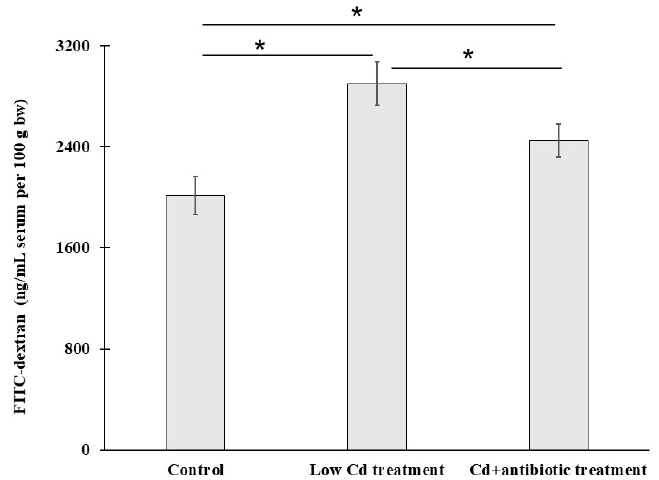
Figure 5. Fluorescein-isothiocyanate-dextran (FITC-dextran) levels in serum from the control and low Cd treatment groups as a measure of intestinal permeability. * p < 0.05.